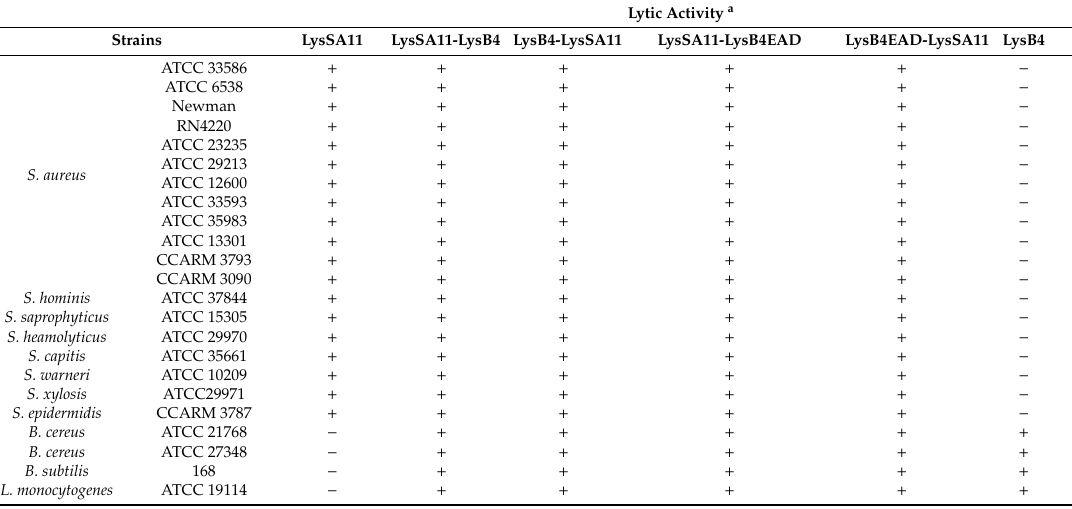
Table 1. The antibacterial spectra of the hybrid